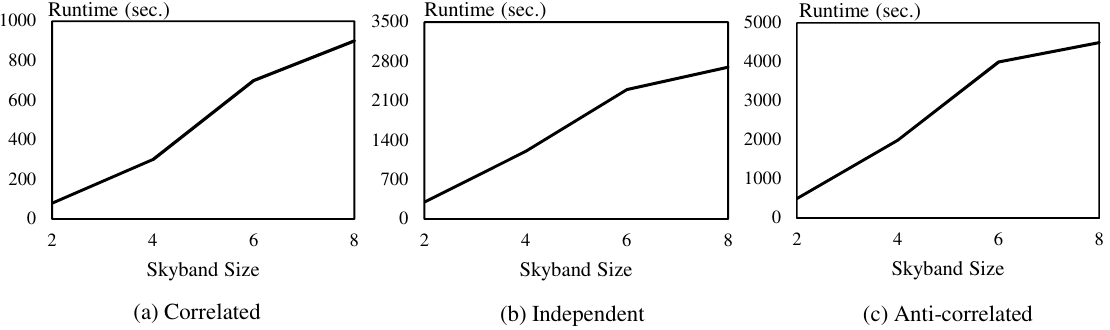
Figure 10. Performances for different skyband